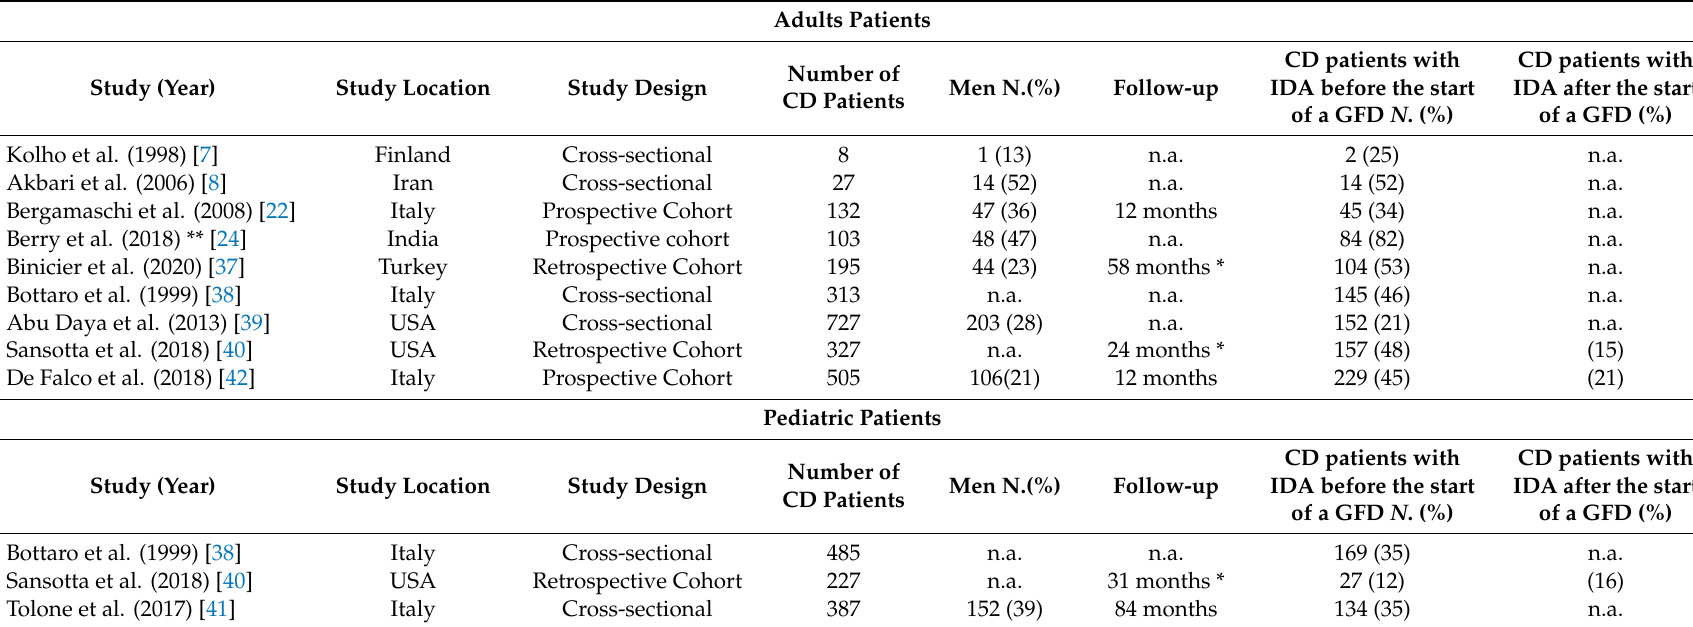
Table 1. Prevalence of IDA at CD diagnosis and after a gluten-free diet (GFD), both in adult and pediatric